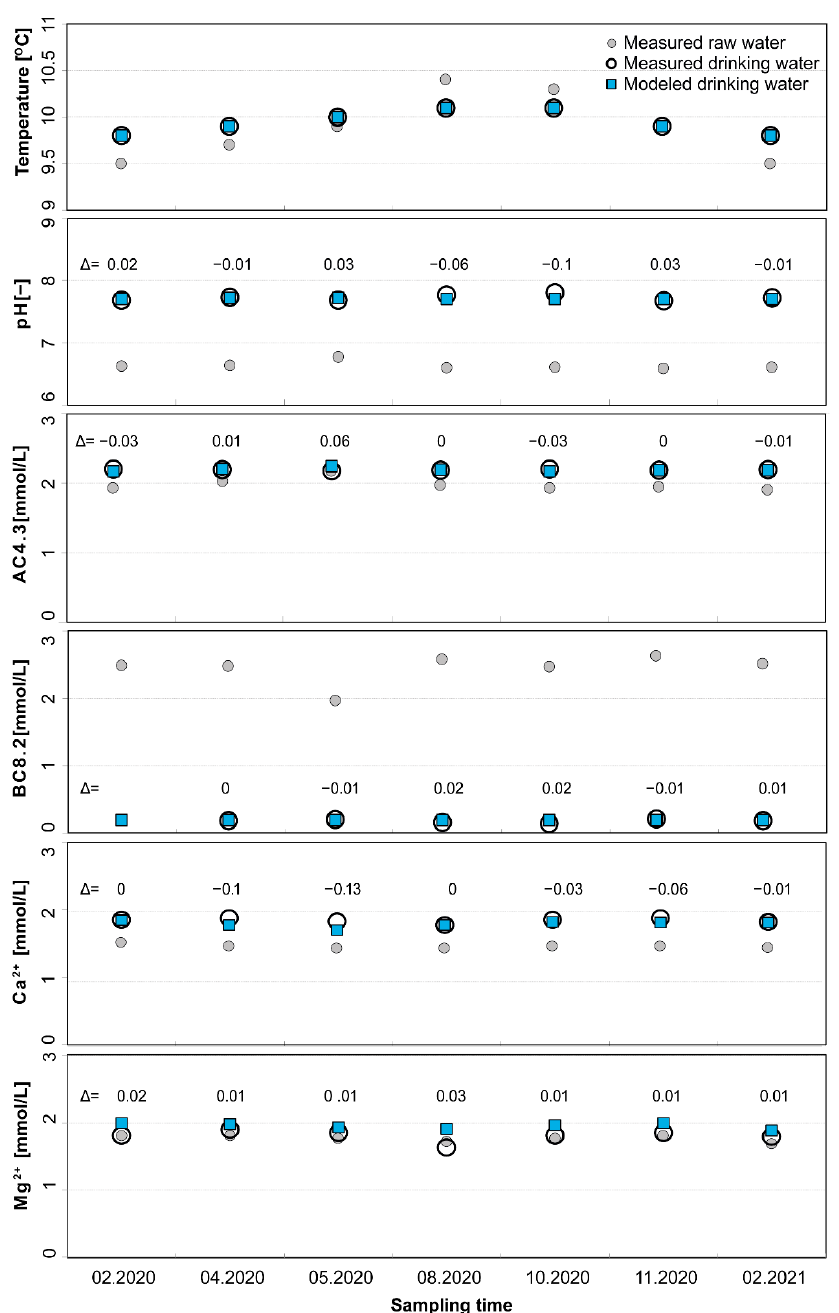
Figure 4. Comparison of the modeled values with the measured values of relevant parameters to temperature and lime–carbonic acid balance; Δ = modeled value of the parameter − measured value of the parameter.